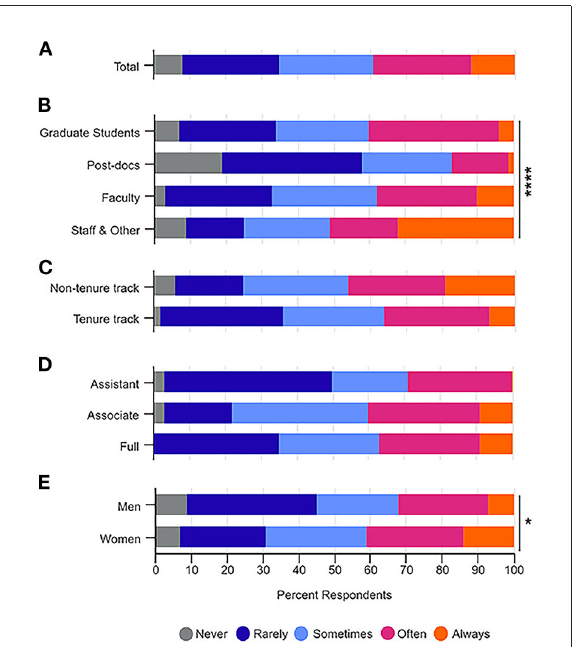
FIGURE1 Comparison of respondents’ participation in science outreach activities. (A) The majority of respondents (65%, n = 344) participate in science outreach at least 3 or more times per year. (B) Participation in science outreach varies by academic role [ X 2 (12, n = 530) = 97.26, p < 0.0001]. (C) There were no differences in participation based on faculty track [X 2 (2, n = 159) = 1.52, p = 0.465] or (D) faculty rank [X 2 (2, n = 106) = 5.96, p = 0.202]. (E) Participation in science outreach differs by gender [X 2 (2, n = 517) = 8.63, p = 0.013]. * p ≤ 0.05; **** p ≤